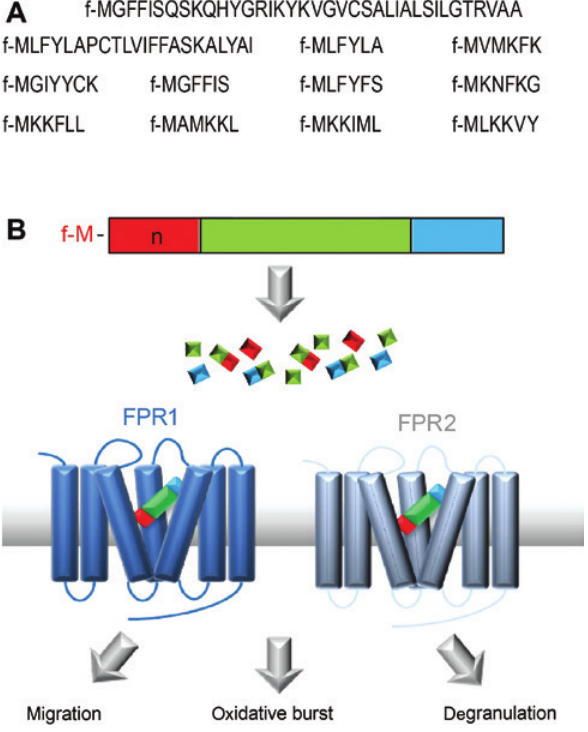
Figure 3: Schematic indicating that a large number of formylated bacterial signal peptides are capable of triggering immune responses by activation of FPR1 and